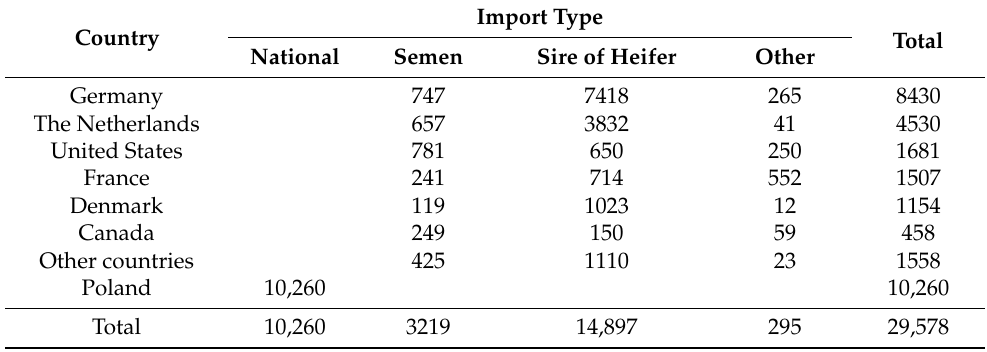
Table 5. Characteristics of populations of Polish Holstein-Friesian (PHF) sires used in Poland depending on the country of origin and method of import to